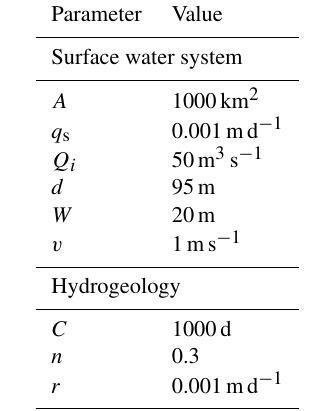
Table 2. Reference parameter values used in sensitivity